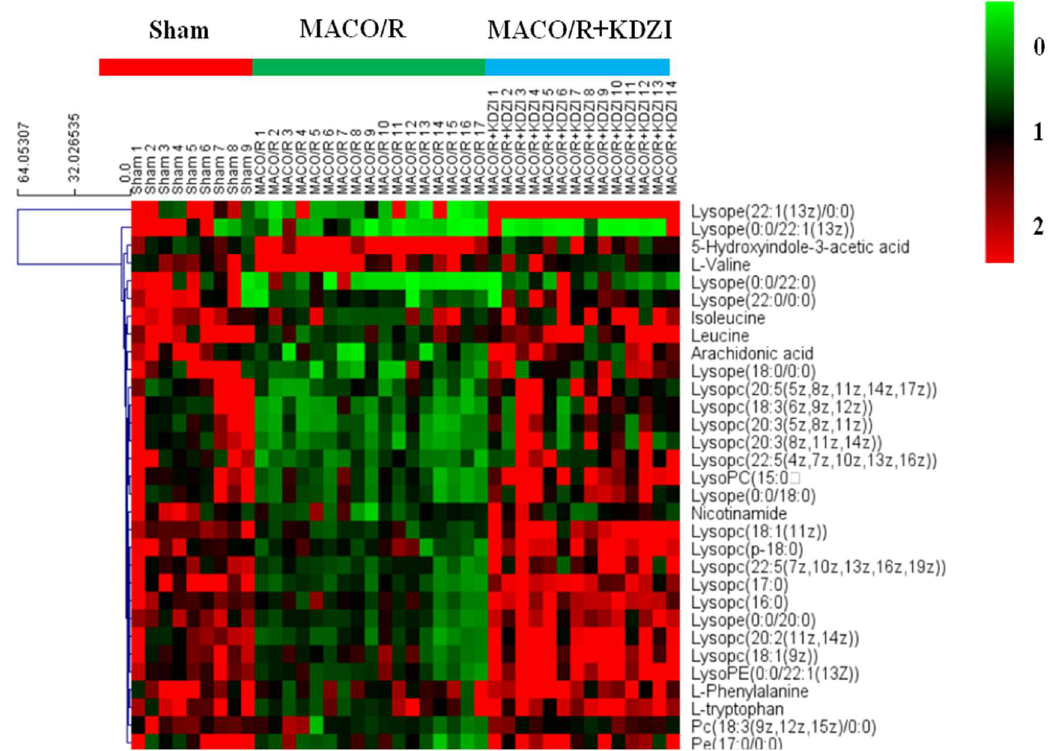
Figure 4. Heatmap of the 32 identified metabolites showing a significant difference among samples from the sham, MCAO/R, and MCAO/R + KDZI groups constructed by using by using the software Multi Experiment Viewer (MeV) v4.8. Rows: potential biomarkers; columns: samples. The color key indicates the relative amounts of metabolites: Light green represents the lowest; light red represents the highest.